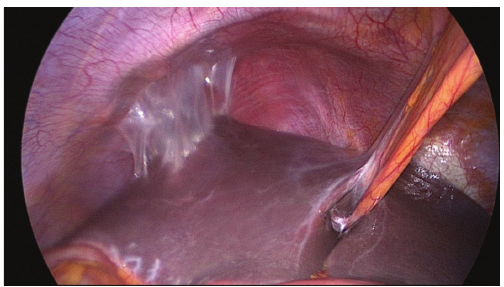
Figure 1: Fallopian tube torsion.